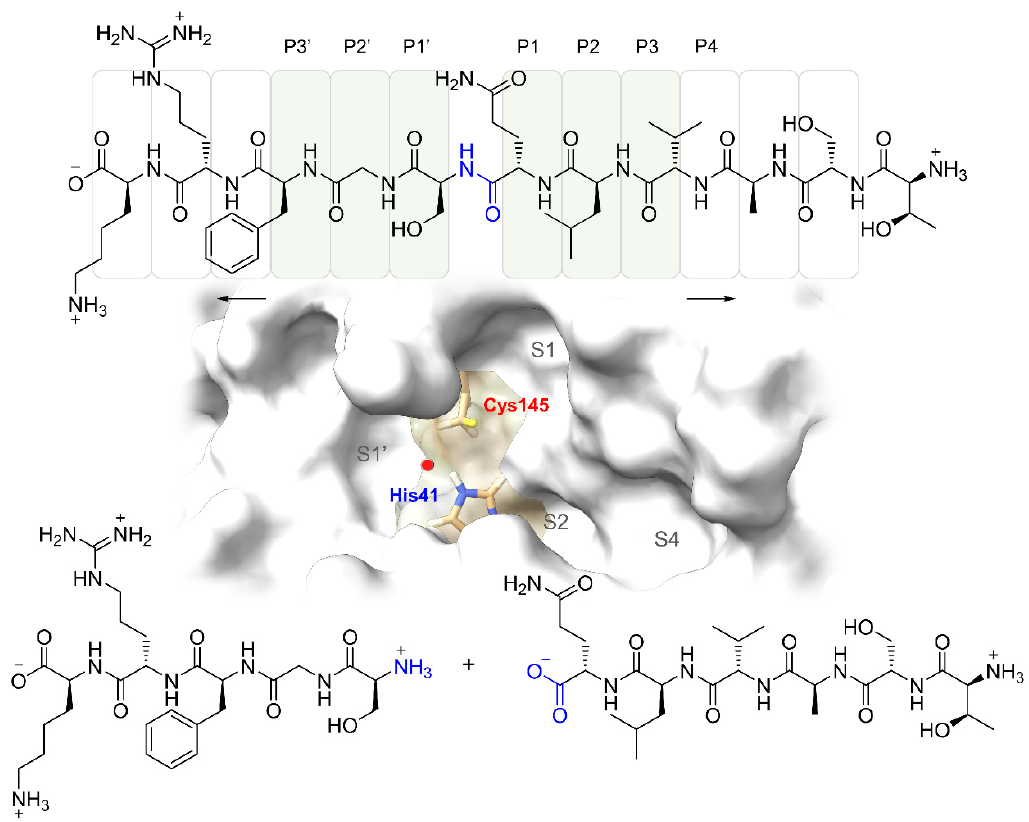
Figure 1. The reaction catalyzed by SARS-CoV-2 M pro . Substrate framework regions that are complementary to the substrate binding sites called S1, S1 ′ , S2, and S4; molecular recognition regions in the protease are highlighted. The catalytic dyad constituted by His41 can also be observed; it plays a relevant role in the ionization of the residues favoring the nucleophilic attack of Cys145, on the amide group of the substrate marked in blue, thus completing the hydrolysis of the peptide bond [7].